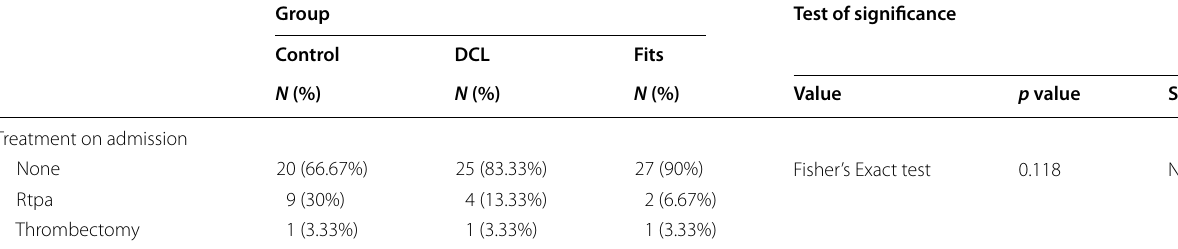
Table 5 Type of treatments the stroke patients received on admission to stroke unit